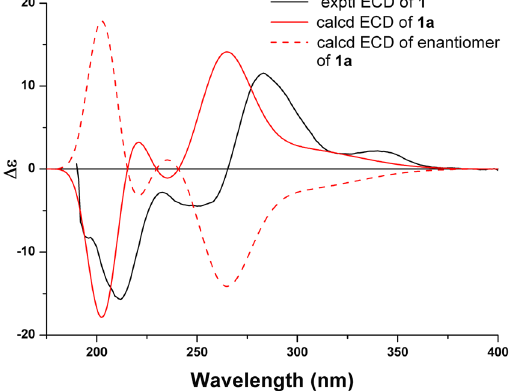
Figure 4. Experimental ECD spectrum of 1 and TDDFT calculated ECD spectra for 1a (1 R , 4 R , 5 R , 6 R , 7 S , 10 R , 1 ′ R ) and enantiomer of 1a